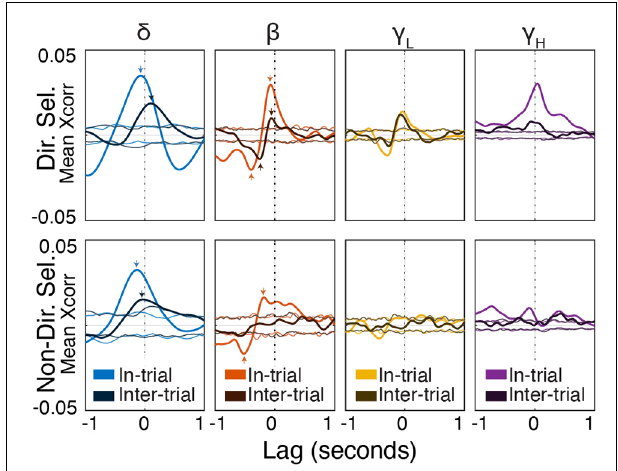
FIGURE 9 | Beta/low-gamma power lags directionally-selective unit spiking during and between trials. Frequency band-specific cross-correlations ( ± 1 s) for directionally selective (top) and non-directionally selective (bottom) units. Thick lines represent the actual cross-correlations; thin lines represent thresholds for significance at p < 0.01 (see “Materials and Methods” section). Small arrows indicate correlations mentioned in the “Results” section. Note that the cross-correlation patterns between directionally-selective units and beta/low gamma power are similar both during and between trials, which is not true for any other unit-frequency band